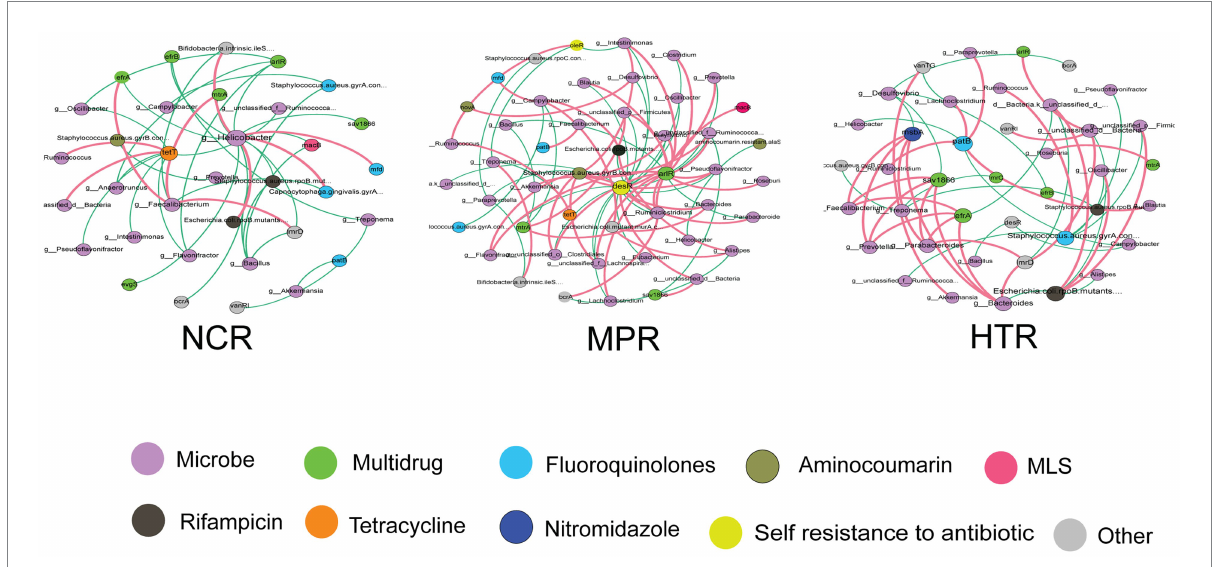
FIGURE 5 Network analysis depicting the patterns of co-occurrence among ARG subtypes and bacterial genera. A link represents a strong correlation (Spearman’s correlation coefficient ρ ≥ 0.6 and p < 0.01). The size of each node and the edge thickness is proportional to the number of connections and the value of ρ , respectively. Line color reflects direction (green: negative; red: